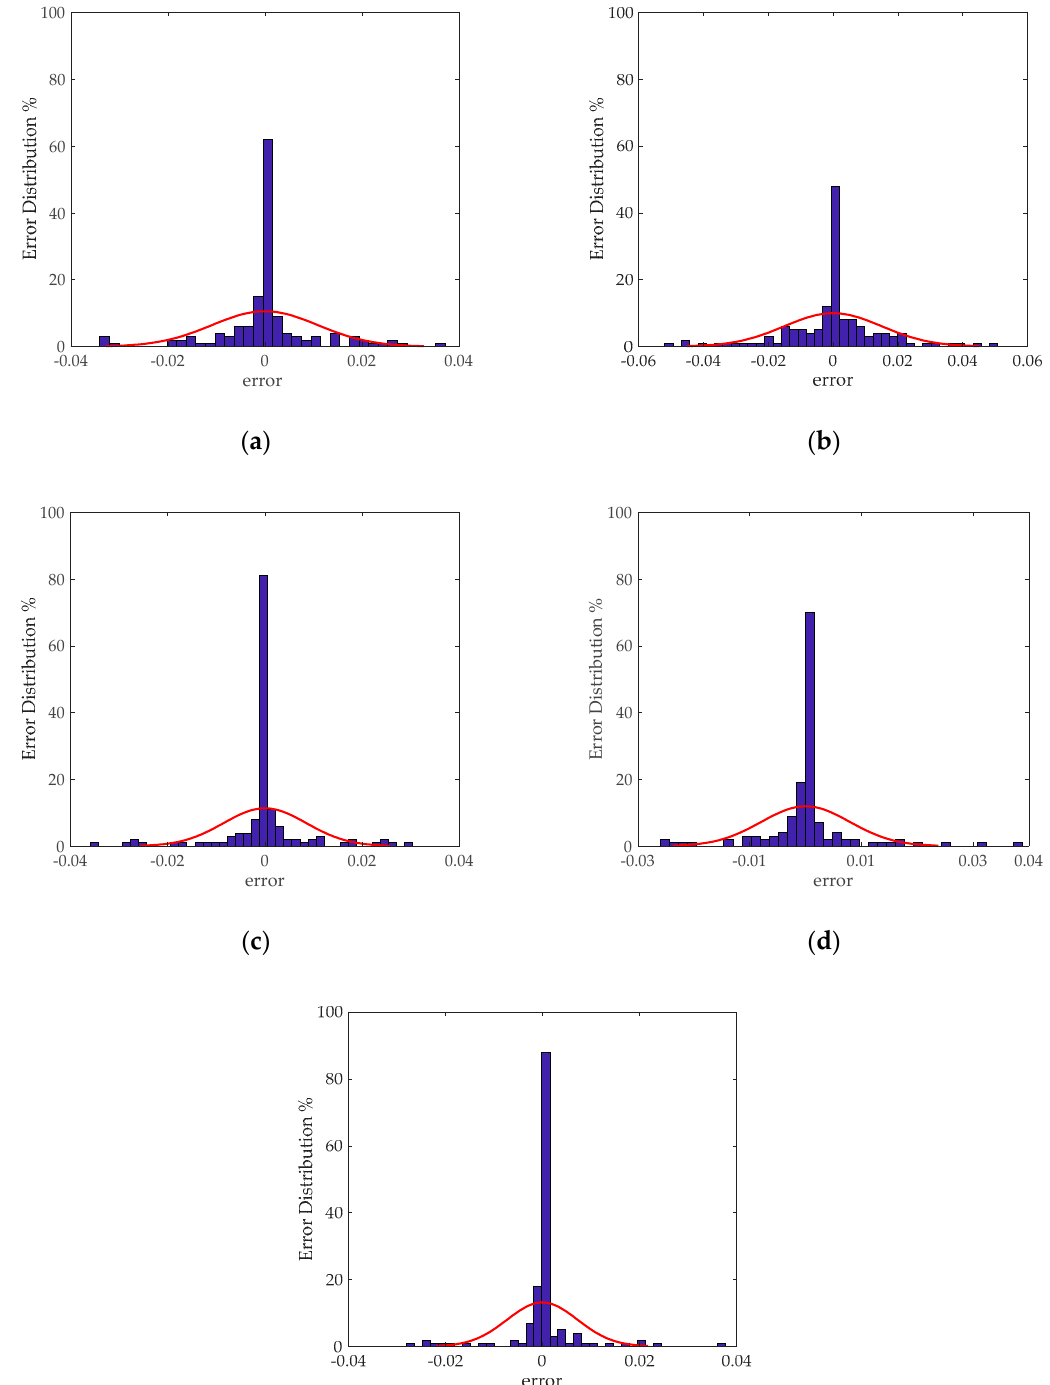
Figure 4. The histogram of the prediction error distribution of five models: ( a ) Optimal BPNN; ( b ) Optimal ELM; ( c ) Optimal RBFNN; ( d ) Fully integrated model; and ( e ) Selective ensemble model.